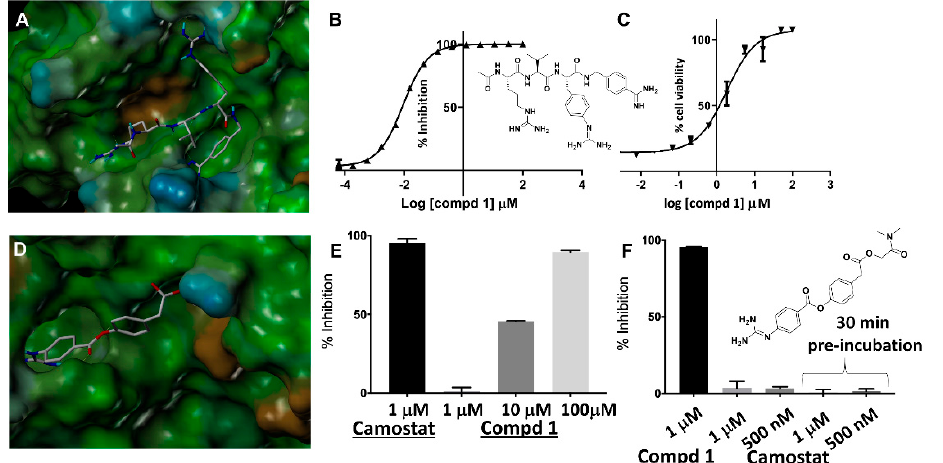
Figure 2. Characterization of the protease inhibitors. ( A ) Docked geometry of compound 1 into the 3D structure of furin. The docked pose was obtained based on the X-ray structure of similar agents in complex with furin (PDB-ID 4OMC) [30]. The docked geometry was obtained based on the structure of the complex using Sybyl (Cetara, St. Louis) and visualized using MOLCAD (surface representation color-coded according to lipophilic potential: brown more lipophilic; cyan less lipophilic). ( B ) Chemical structure of compound 1 and dose response curve for inhibition of furin by compound 1 . ( C ) Dose response curves for the protection of RAW macrophages by lethal factor/protective antigen (LF/PA) apoptosis by compound 1 . ( D ) Docked geometry of camostat in a modeled structure of TMPRSS2 catalytic domain (obtained via Swiss3D model and bovine trypsin as template, PDB ID 3MFJ). ( E ) Inhibition of bovine trypsin by camostat, as a reference, and compound 1 at the indicated conditions. ( F ) Chemical structure of camostat and inhibition of furin by compound 1 and camostat at the indicated conditions.